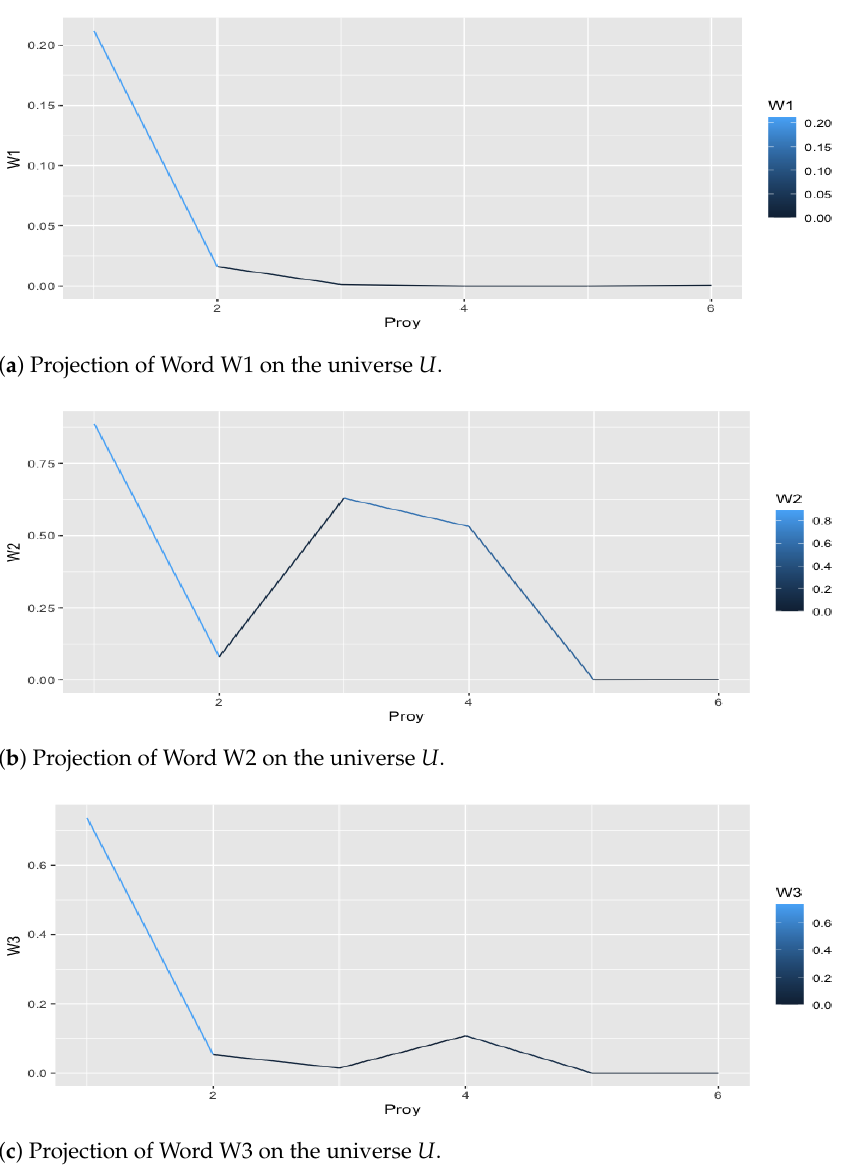
Figure 2. Semantic projections of the words that define A on the universe U